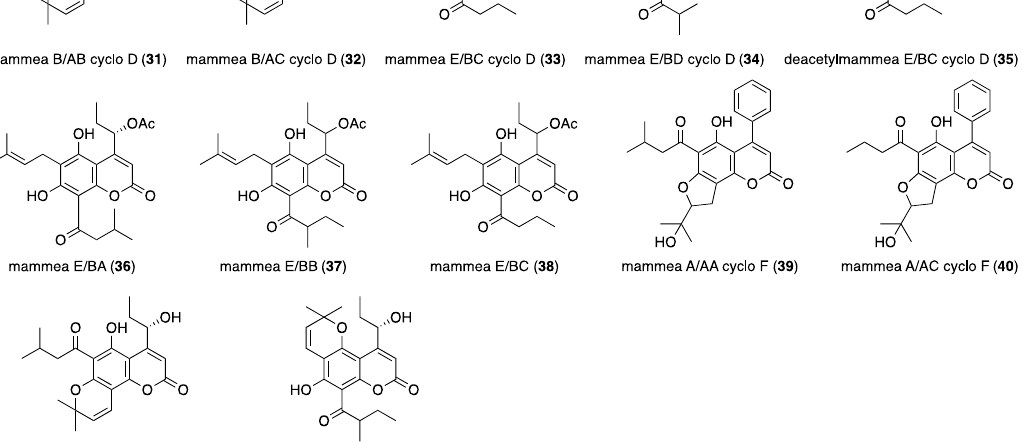
Figure 5. Coumarin constituents ( 6 – 42 ) from the flowers of M. siamensis.